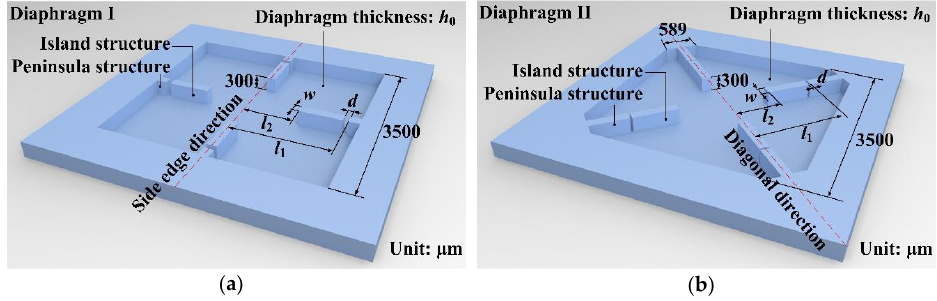
Figure 8. Schematics of the peninsula-island based diaphragms structures: ( a ) diaphragm I with peninsula-island structure positioning along the side edge direction of diaphragm; ( b ) diaphragm II with peninsula-island structure positioning along the diagonal direction of diaphragm.